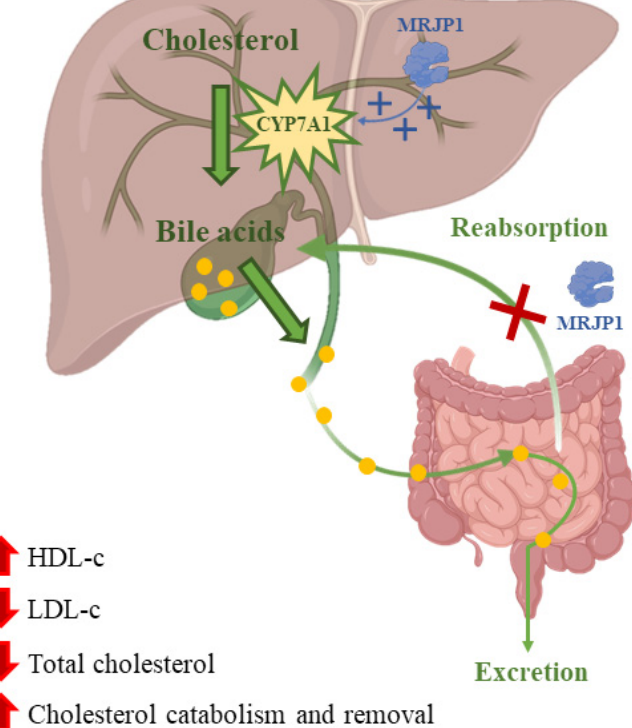
Figure 3. Cholesterol is converted into bile acids catalyzed by the enzyme cholesterol 7- α -hydroxylase (CYP7A1). Bile acids are then excreted or reabsorbed at the jejunum. MRJP1 upregulates the expression of CYP7A1 increasing bile acids synthesis and their excretion. In addition, MRJP1 can inhibit cholesterol and bile acid reabsorption.